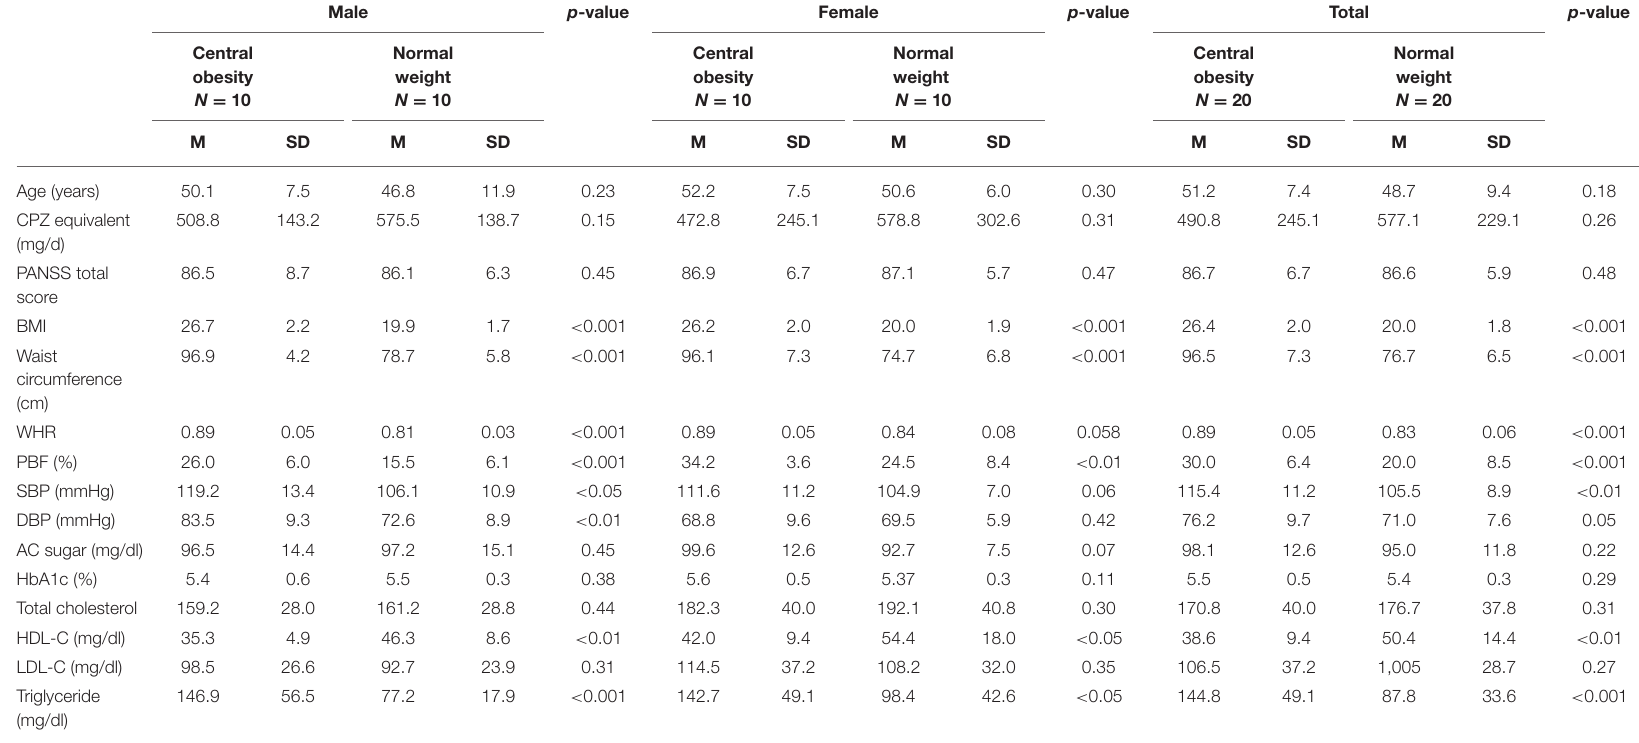
TABLE 1 | Demographic and clinical characteristics of studied